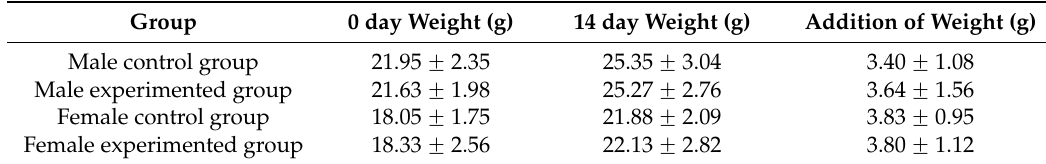
Table 1. Body weights of mice in the acute toxicity test.